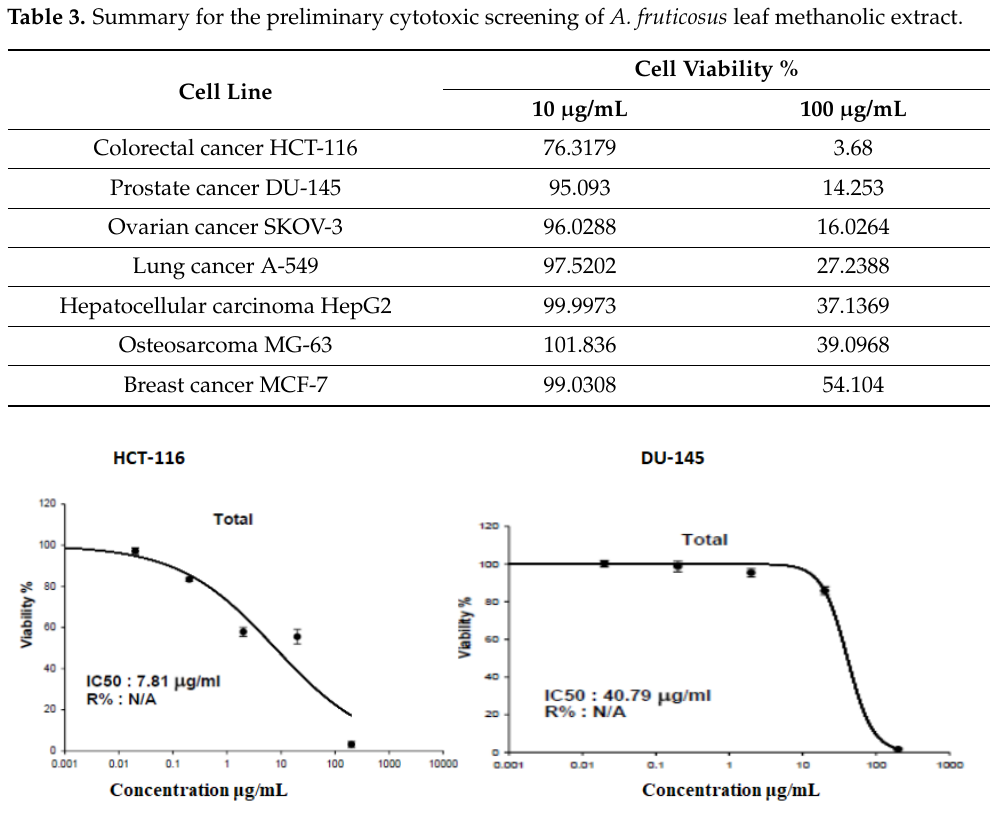
Figure 12. Dose response curves for the methanolic extract of A. fruticosus against HCT–116 and DU–145 cell lines.